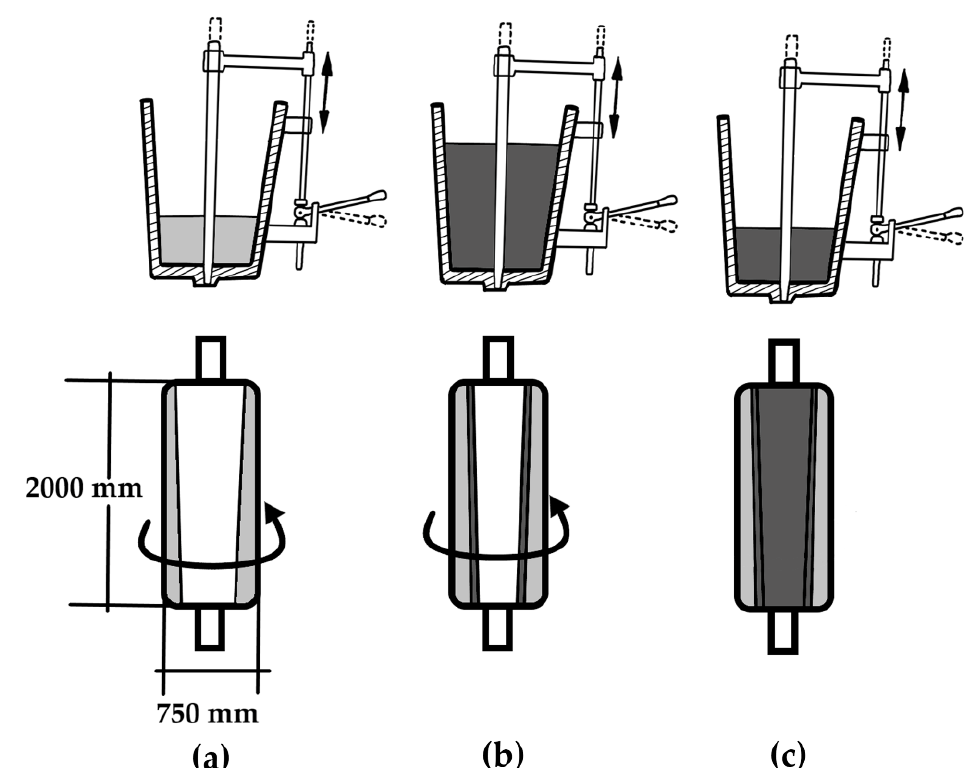
Figure 1. Manufacture by centrifugal casting: ( a ) casting of outer working layer; ( b ) casting of the core intended to achieve an optimal bond with the outer working layer; ( c ) casting of the remainder of the core and roll necks by gravity and static solidification.